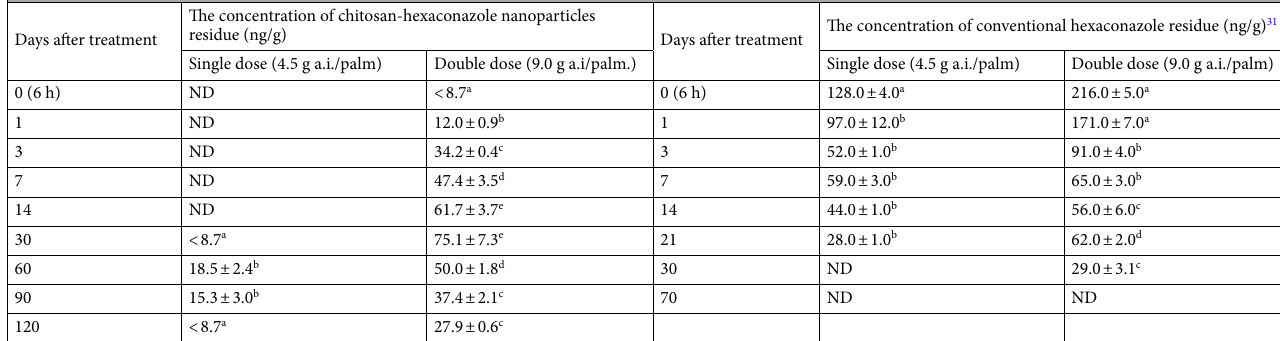
Table 4. The accumulation of chitosan-hexaconazole nanoparticles and conventional hexaconazole residue found on the leaf, where different letters in the same column indicate significant differences between means (p ≤ 0.05) according to Tukey’s test. ND not detected.